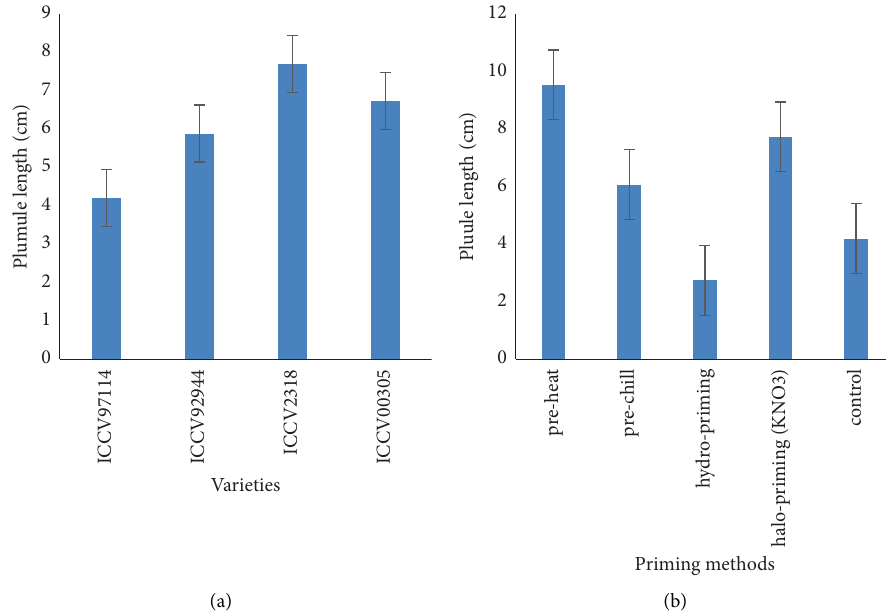
Figure 4: Efect of variety and priming method on plumule length of chickpea. Vertical bars represent standard error bars of